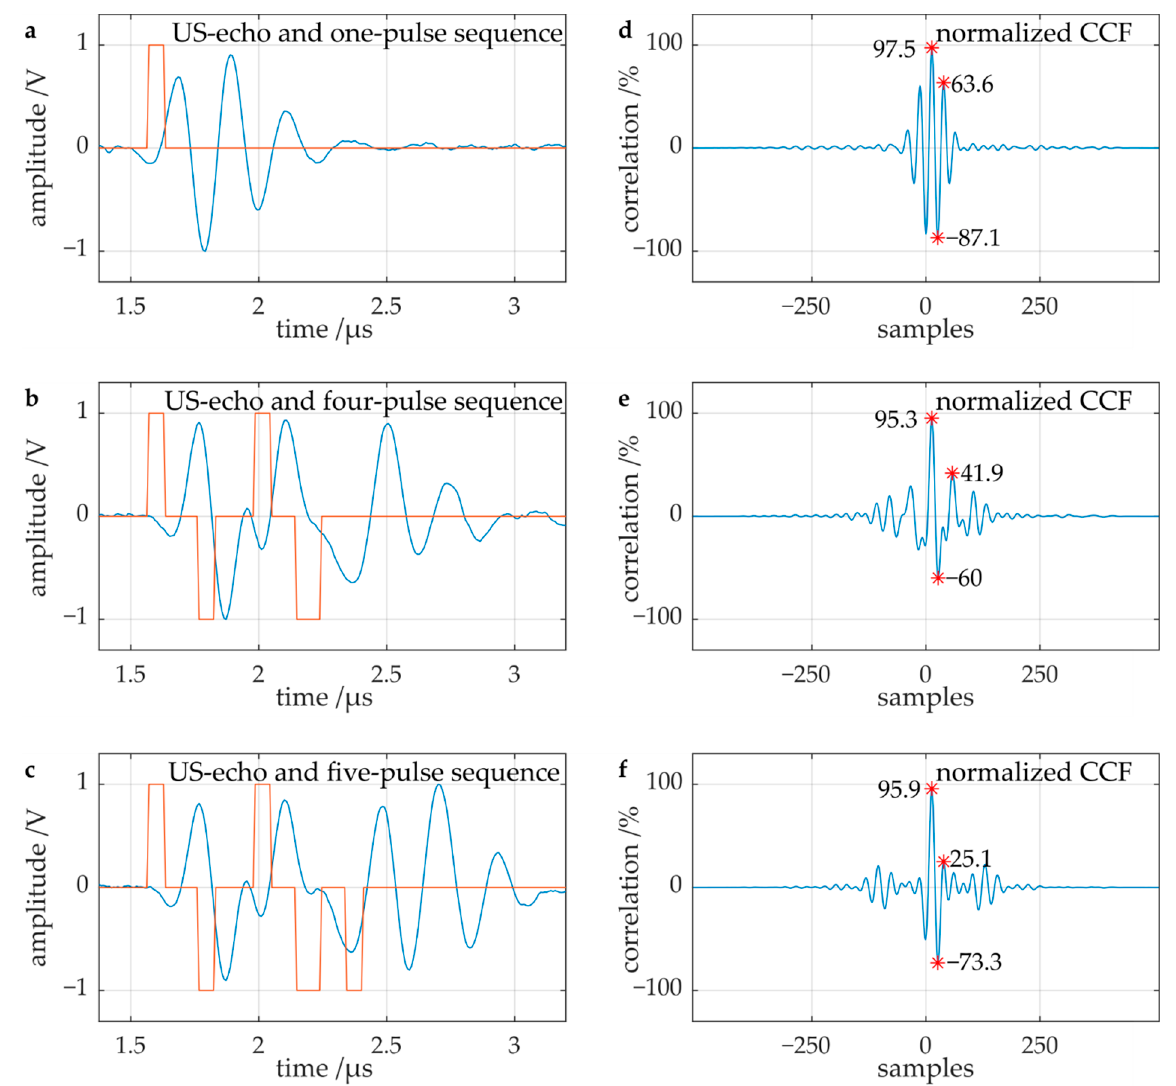
Figure 5. Empiric optimization of ultrasound echoes, ( a – c ) pulse sequences (normalized to 1 V) (orange) and related ultrasound echoes (blue), ( d – f ) Normalized CCF of the ultrasound echoes for pulse sequences. The * markers highlight the extrema of the CCF. Table 2. Comparison of the magnitude of positive and absolute side maximum of the CCF for the validation measurements on the steel samples with different thicknesses.